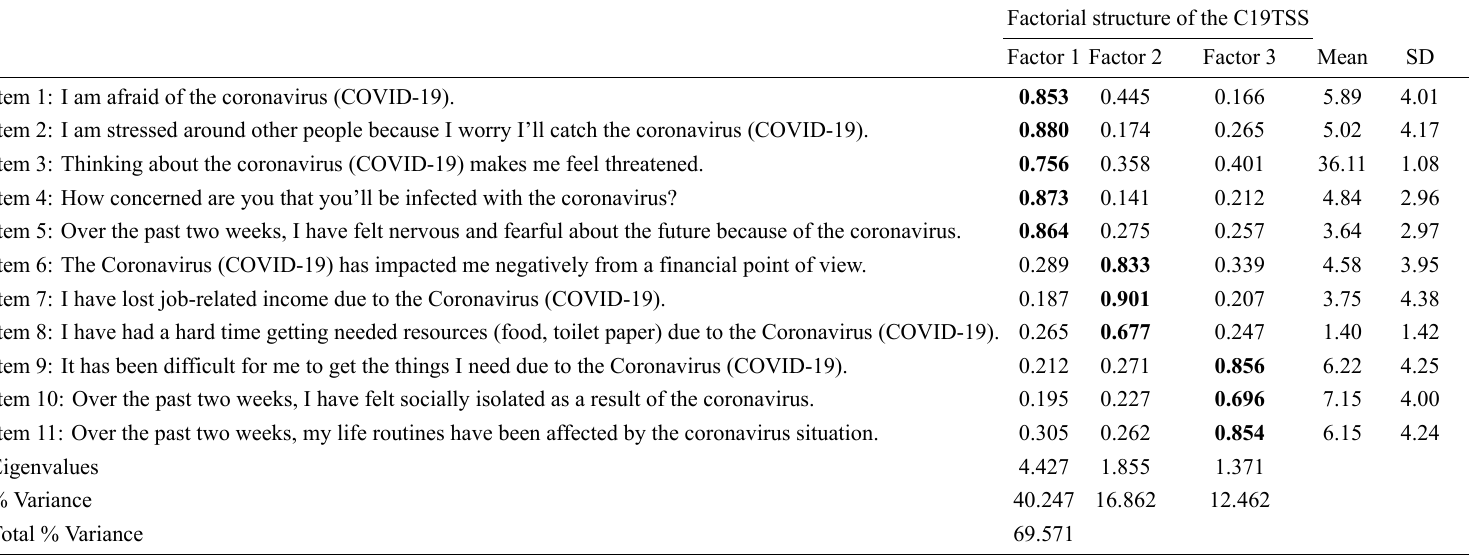
Table 1. Exploratory Factor Analysis (EFA) of the Portuguese version of the COVID-19 Traumatic Stress Scale (C19TSS) with model 1 (N = 220).